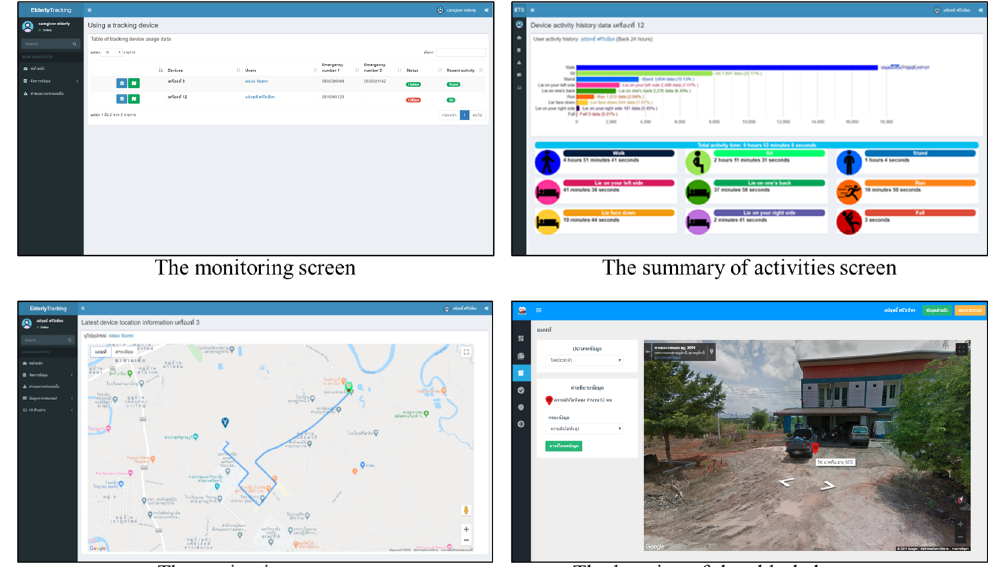
Figure 11. Examples of the activity tracking screen.